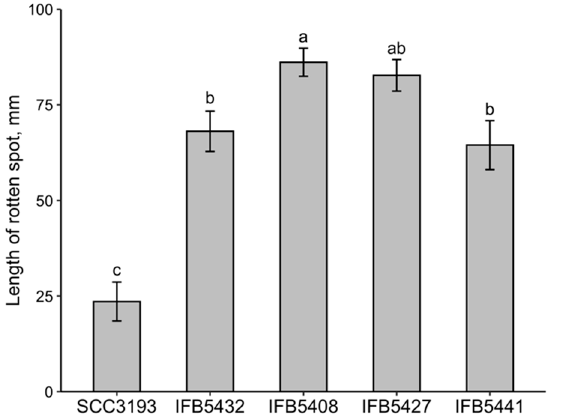
Figure 4. Comparison of the ability of P. parmentieri strains to cause disease symptoms on chicory leaves. Means ± SE of the lengths of the rotten spots on chicory leaves are depicted. Three independent experiments with 11 technical replications were conducted. Means marked with different letters (a, b, c) are significantly different according to the Kruskal–Wallis test followed by a posthoc analysis applying Fisher’s least significant criterion at p < 0.05 (H = 67.6, df = 4, p < 0.001).